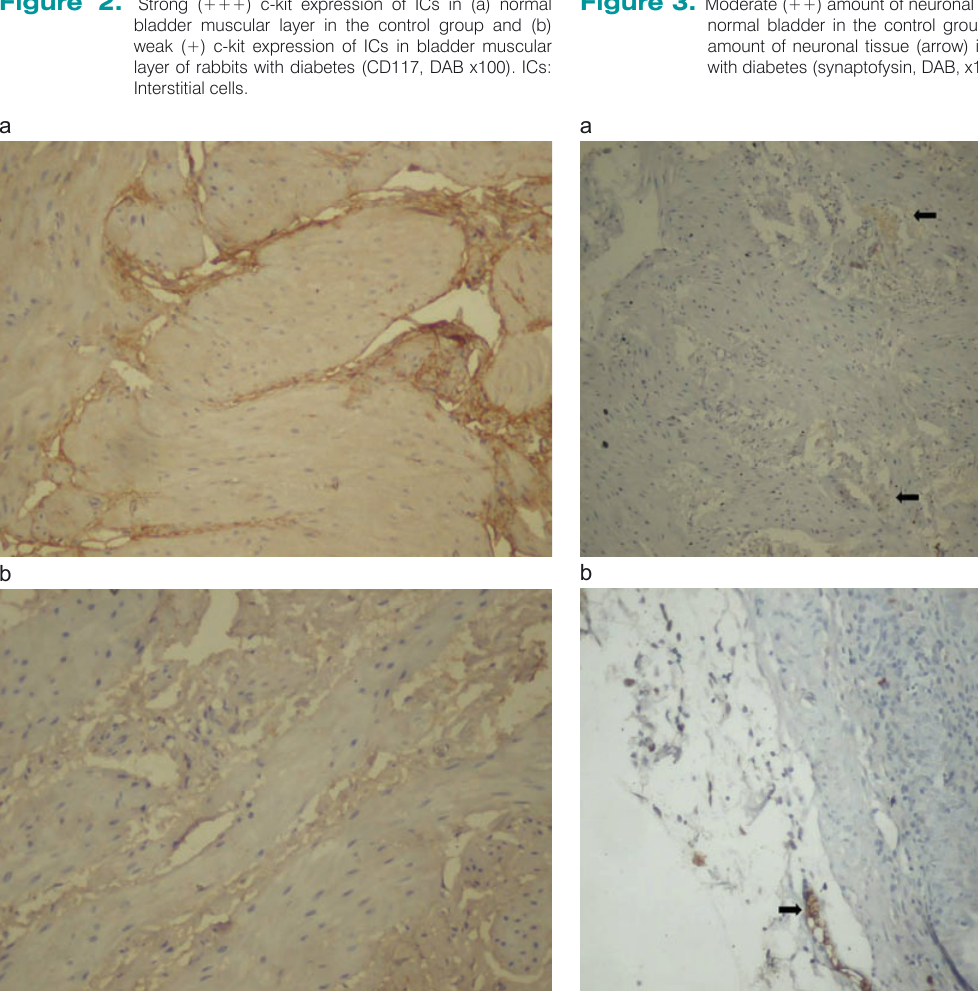
Figure 3. Moderate (++) amount of neuronal tissue (arrows) in (a) normal bladder in the control group and (b) weak